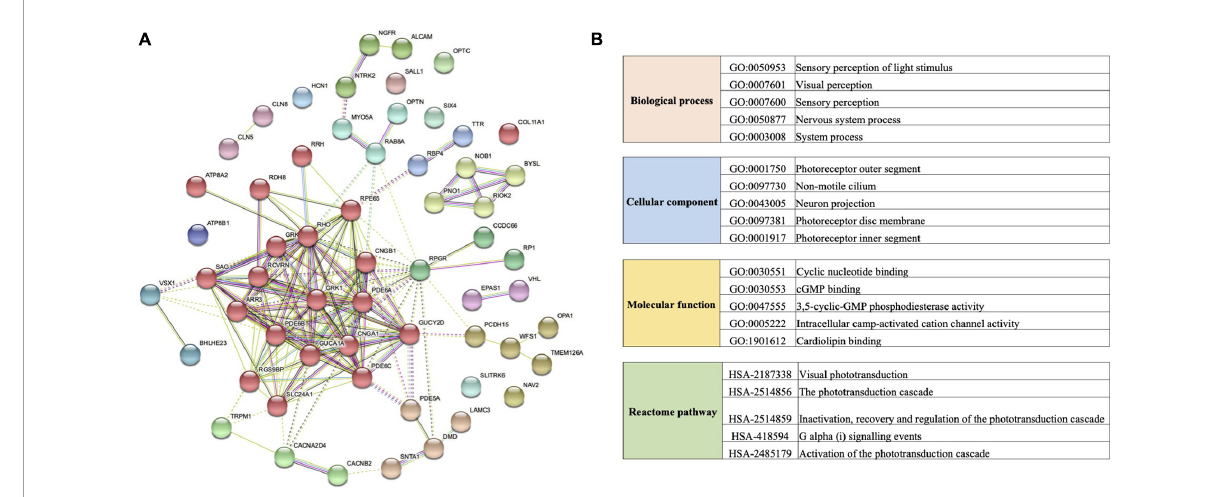
FIGURE4 Protein interaction network and functional enrichment of vision genes with specific amino acid replacement in the crepuscular genus Macropus . (A) Protein–protein interaction network generated using the STRING database. Lines between each node indicate inferred or experimentally demonstrated biological associations. (B) Gene ontology (GO) term and Reactome pathway enrichments of genes examined in (A)